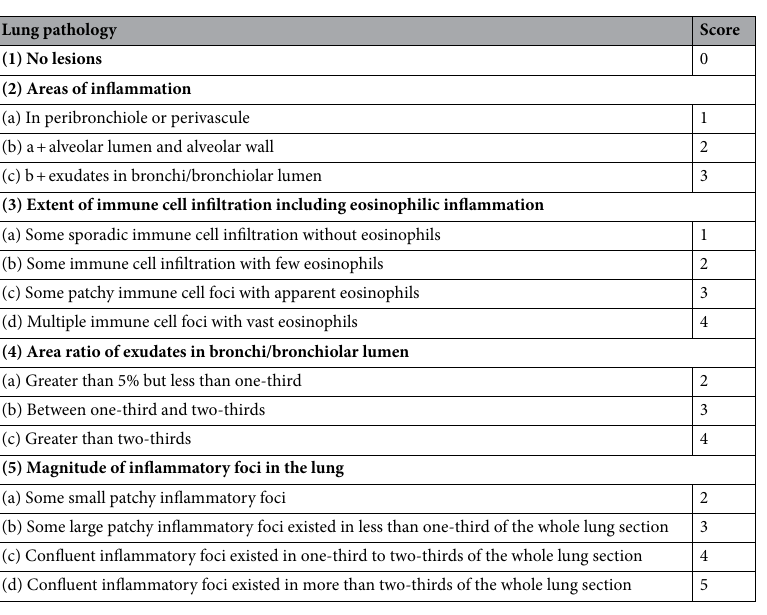
Table 1. Lung pathology scoring